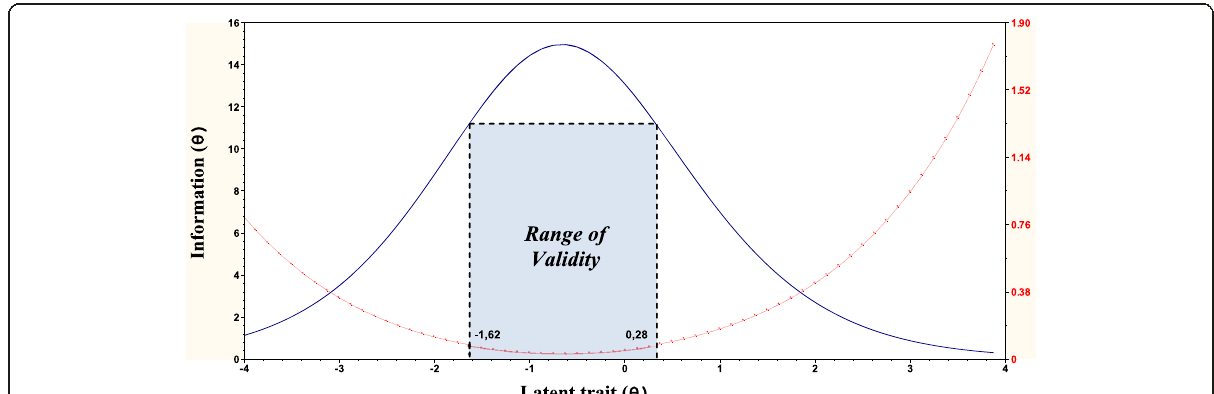
Fig. 2 Range of validity of BISOC with the lower and upper bounds for item